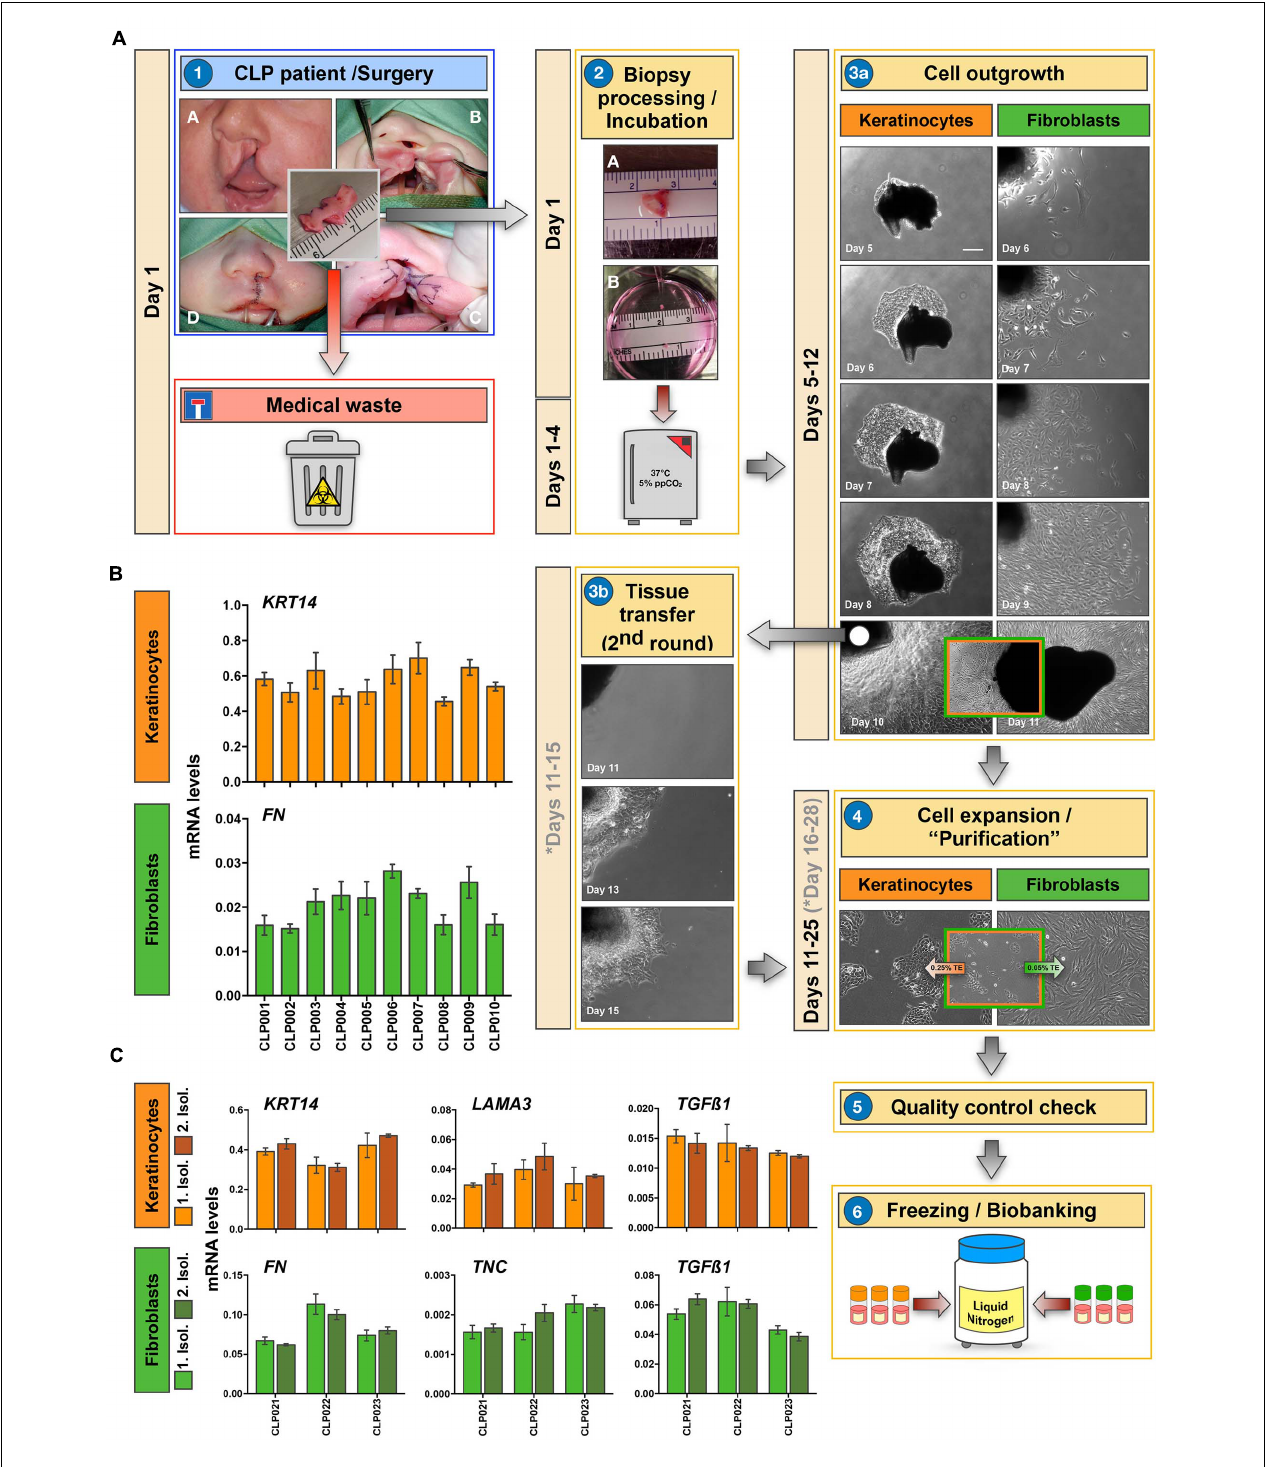
FIGURE 2 | Establishment of a robust and reproducible method for the isolation of keratinocytes and fibroblasts. (A) Illustration of the process we follow for the isolation of patient-derived cells from tissue biopsies. A representative example for a CLP biopsy is shown. Briefly, lip tissue from a corrective CLP surgery, which would be routinely discarded (medical waste), is collected in Collection Medium (CM) and transferred to the laboratory (1). After mincing the tissue biopsy, two small tissue fragments of about 0.1 mm 3 are put in one well of a six-well culture plate containing 800 µ l of CM (2). These six-well plates are then incubated at 37 ◦ C/5% CO 2 , re-fed every other day, and observed under the microscope for cellular outgrowths (3a). After approximately 10 days, outgrowths are usually ready for